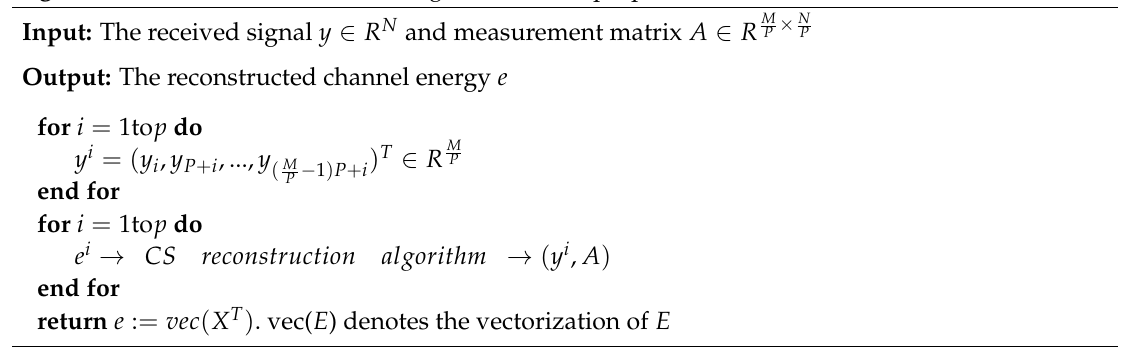
Algorithm 1 Parallel reconstruction algorithm of the proposed STP-CSS